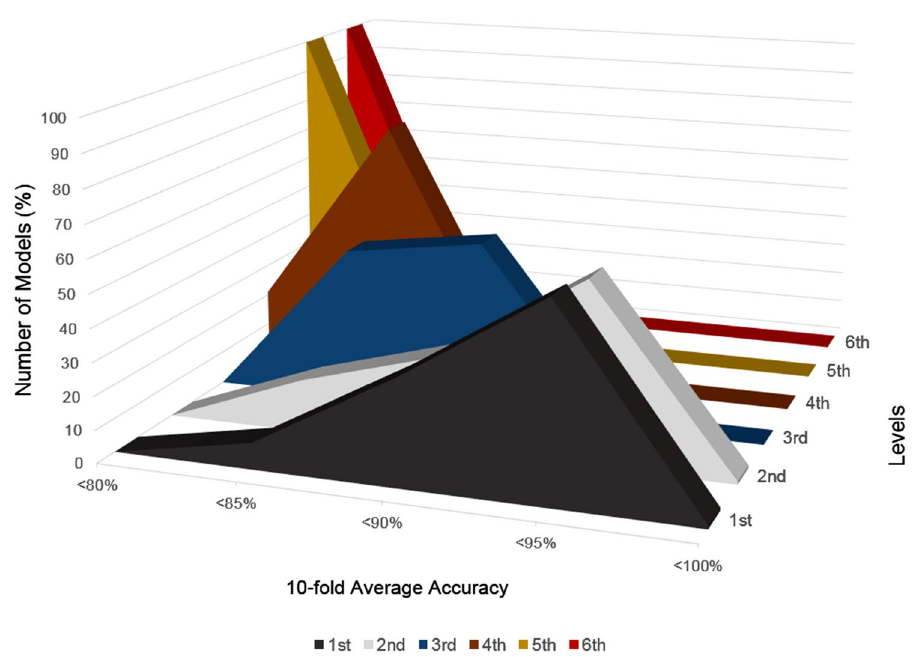
Figure 2. Performance analysis among different levels of wavelet packet transform: the first and second levels exhibit high accuracies while in higher levels of decomposition the texture analysis error is significantly affected. (Figure created in Excel 2013, https:// www. micro soft. com/ micro soft- 365/